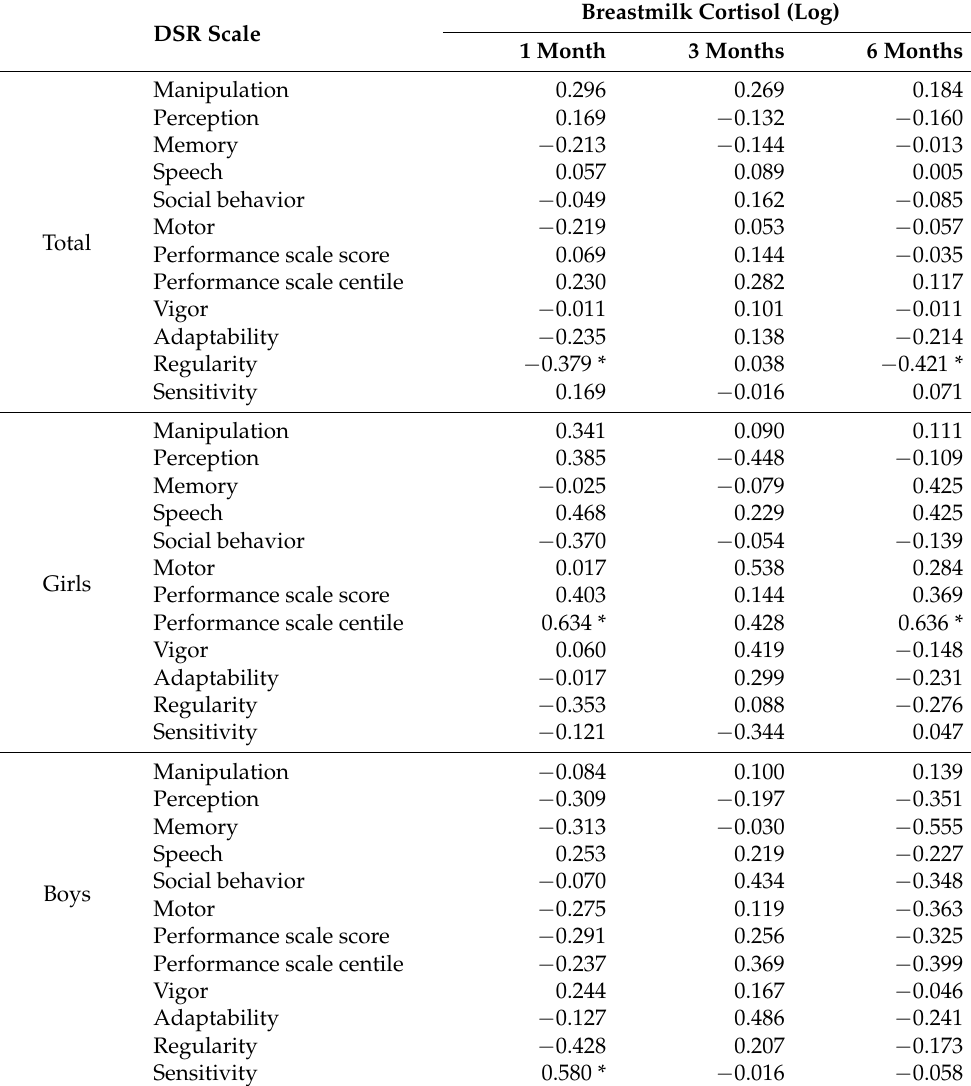
Table 7. Partial correlations between breastmilk cortisol (log) and infant psychomotor development and temperament at the 6th month of life adjusted for infant sex (in the total group) and age, birthweight maternal age, education, psychological status, and